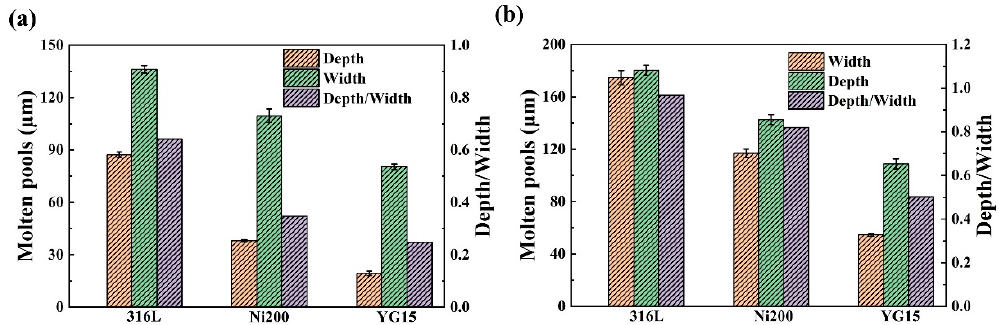
Figure 7. The molten pool size: ( a ) the size of the molten pool formed at a laser power of 125 W; ( b ) the size of the molten pool formed at a laser power of 185 W.